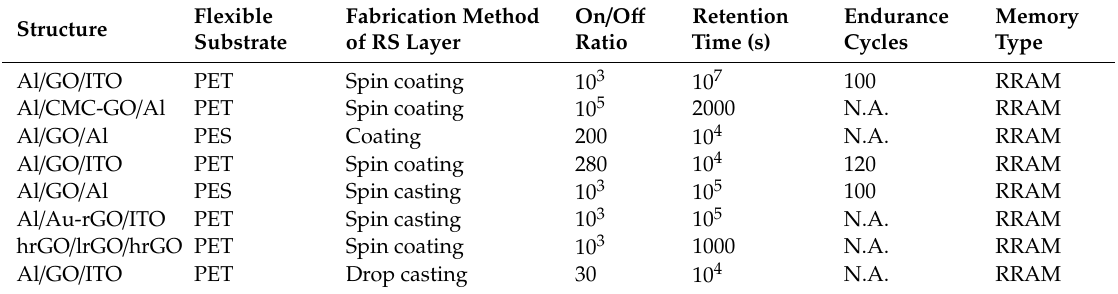
Table 5. Flexible memristive devices with GO-based materials [121,124,145,163,184–187].